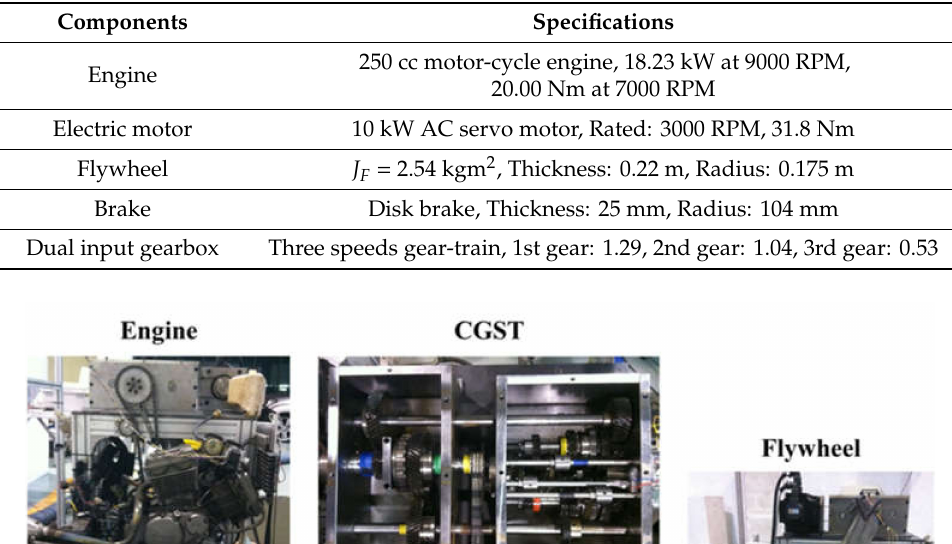
Table 2. Specifications of the developed test-rig.